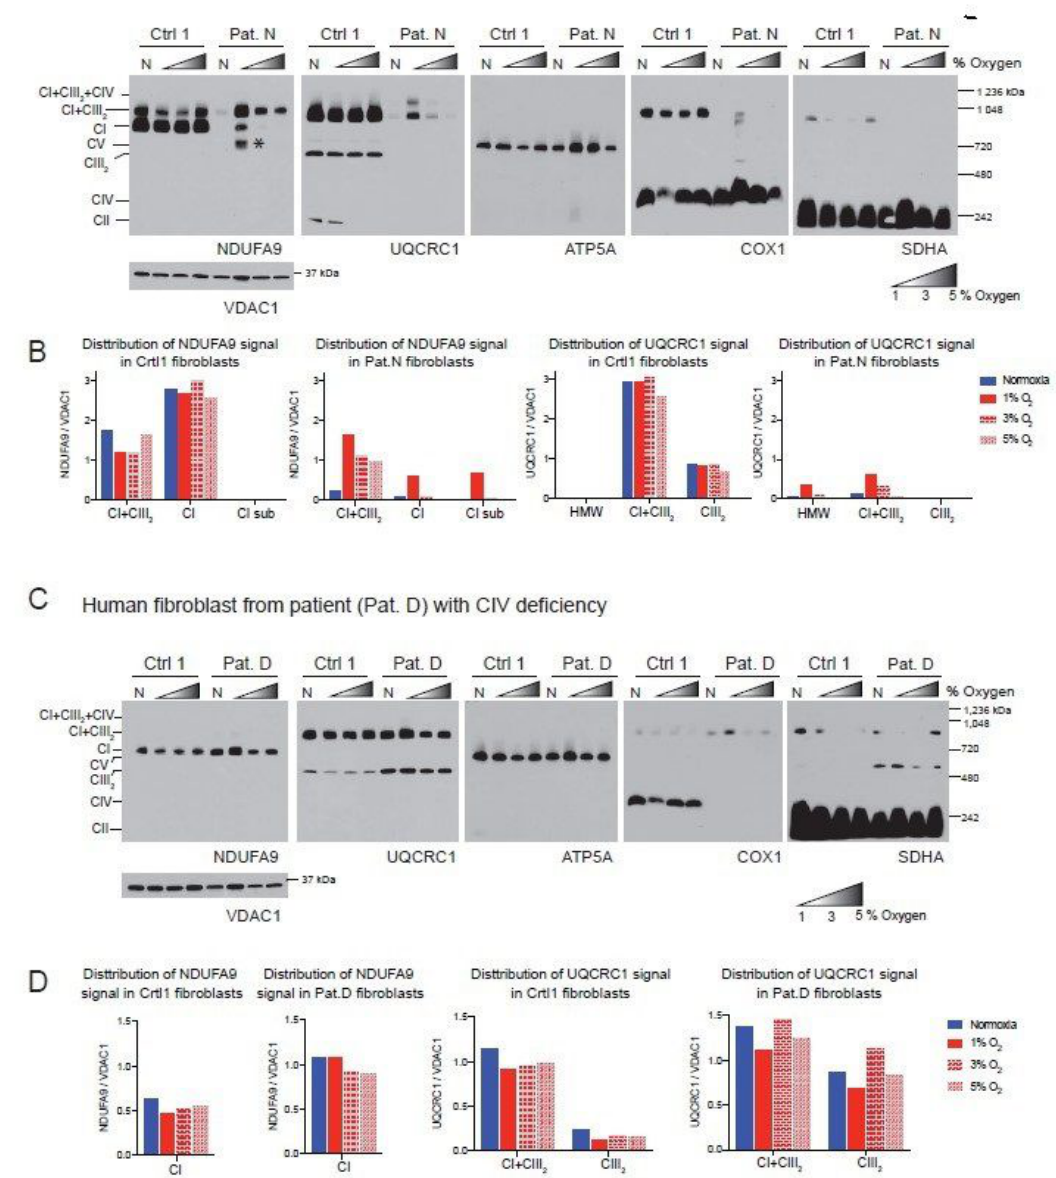
Figure 3. E ff ect of hypoxia in the stability of CI in patient fibroblasts with defects in CIII and CIV. ( A ) Control 1 and Patient N (Pat.N) fibroblasts with a defect in CIII caused by a mutation in the CYC1 gene were exposed to normoxia (N, 21% oxygen), 1, 3 and 5% oxygen for 24 h. Mitochondrial proteins were extracted with digitonin and OXPHOS complexes and SCs analyzed by BN-PAGE followed by Western blot using antibodies against respiratory complex subunits. Shaded triangles represents increasing oxygen concentration (1, 3 and 5% oxygen). The positions of each respiratory complex and SC, as well as molecular weights, are indicated in the figure. Pat.N exhibited a pleiotropic e ff ect in CI in normoxia and no assembly is observed. When exposed to 1% oxygen, CI assembly is stabilized and an assembly intermediary (* of about > 720 kDa), fully assembled CI and SC CI + CIII 2 can be observed in the NDUFA9 panel. At higher oxygen concentrations, CI was observed only in SC CI + CIII 2 . CIII assembly, which is defective in Pat.N, is also stabilized by exposure to low oxygen and CIII and found in CI + CIII 2 arrays and not as a free complex in the UQCRC1 panel. ( B ) Densitometry